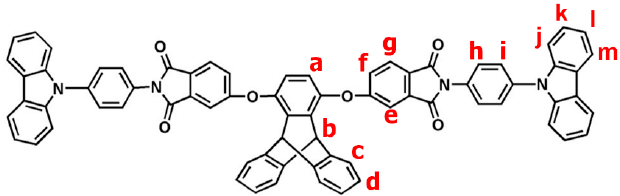
Figure 2. Structure and codes of hydrogen atoms of N -phenylcarbazole triptycene diimide (TPA-TPDI).